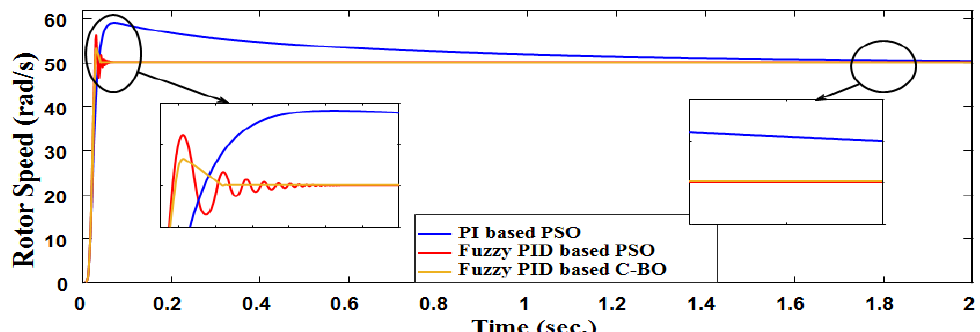
Figure 16. The rotor speed for the desired speed, 50 rad/s, at zero load. Table 7. Speed controller performances at different loading values, 1000 W/m 2 , 1 Atm, and 20 °C.